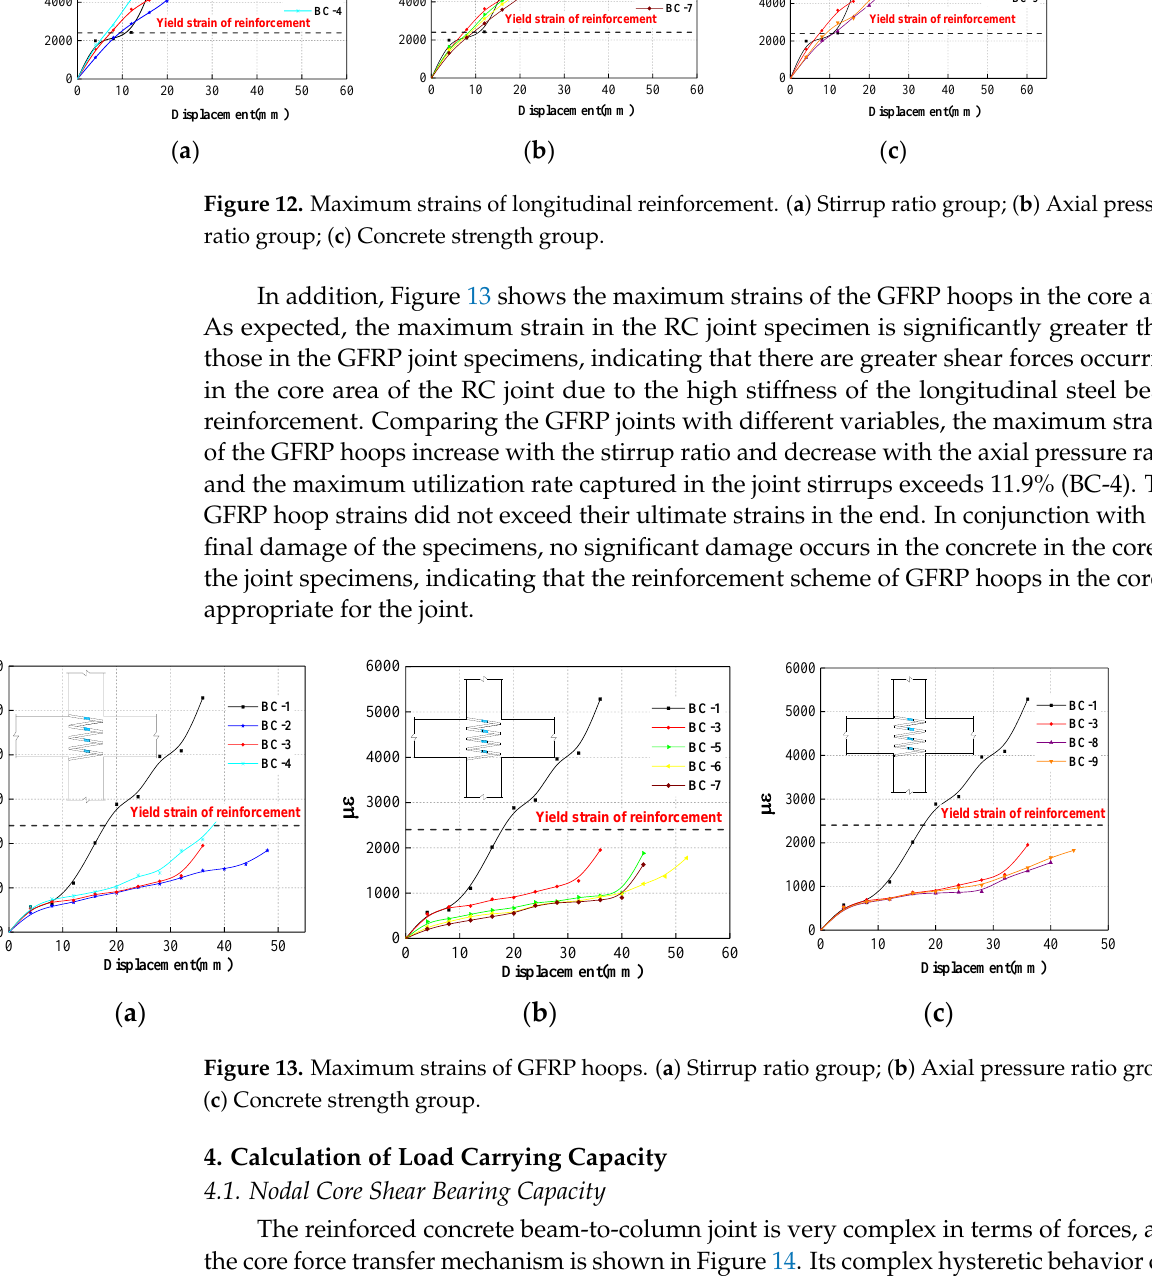
( c ) Figure 11. Stiffness degradation of joint specimens. ( a ) Stirrup ratio group; ( b ) Axial pressure ratio group; ( c ) Concrete strength group. 3.4. Stress – Strain Relationship Strain gauges were arranged along the GFRP longitudinal bars at the end area of the beam in each specimen. Figure 12 shows that the maximum strains observed in the GFRP longitudinal bars are less than half of the rupture strain (approximately 23,000 μ), in dicat- ing that the damage of the GFRP bars takes the form of gradual softening without brittle rupture failure. Compared with the RC joint specimen, the strains of the GFRP joint spec- imens grow slowly without a sudden increase. The strains of the GFRP joint specimens